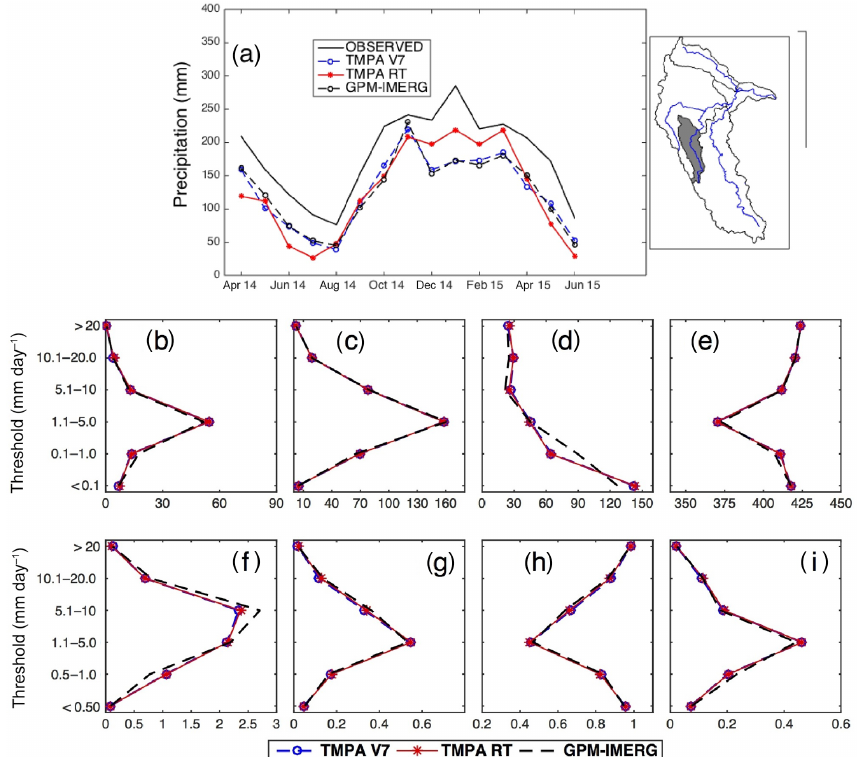
Figure 3. (a) Average monthly rainfall for each precipitation dataset in the Huallaga Basin up to the Chazuta station, (b) the number of observed rain events correctly detected, (c) the number of observed rain events not correctly detected, (d) the number of rain events detected but not observed (false alarms), (e) the sum of cases when neither observed nor detected rain events occurred, (f) coefficient frequency bias index (FBI), (g) probability of detection (POD), (h) false alarm ratio (FAR) and (i) equitable threat score